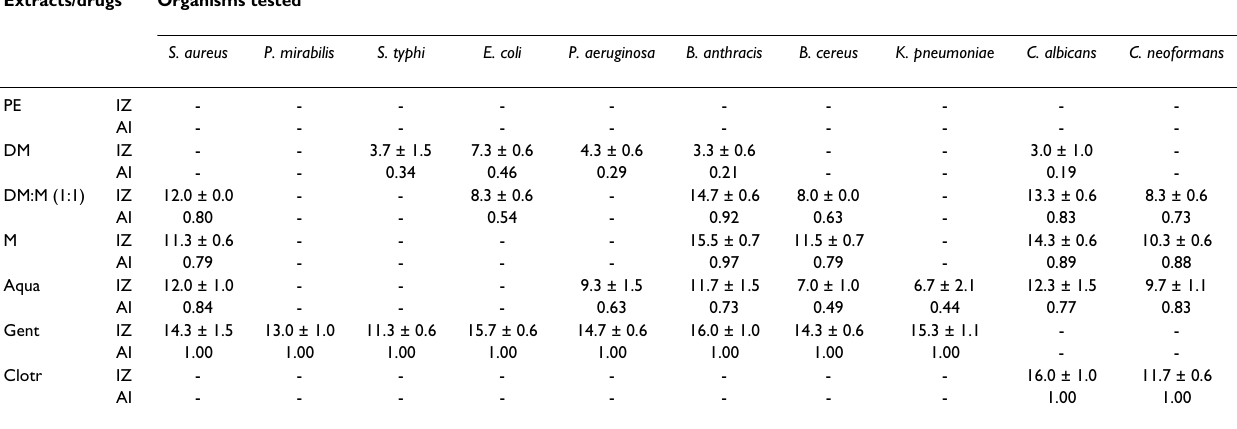
Table 2: Antimicrobial activity of T. brownii stem wood extracts Extracts/drugs